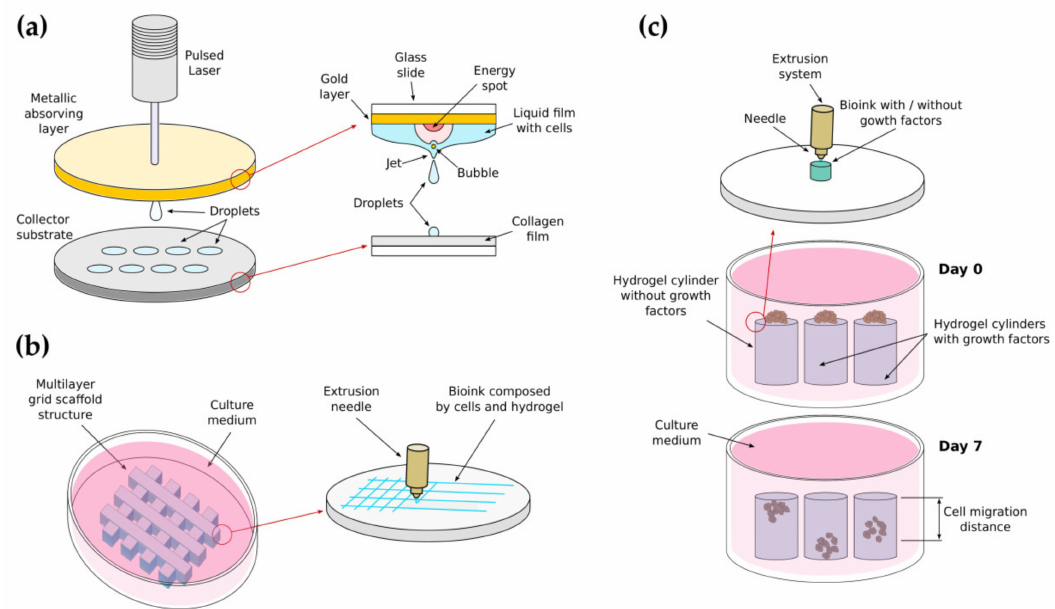
Figure 5. Bioprinted devices for cell migration assays. ( a ) Patterned bioprinted scaffold for cultivating endothelial cells and mesenchymal cells in collagen (Adapted from [291]); ( b ) Grid-shape-cubic scaffold for modeling lung cancer invasion/migration assays (Adapted from [292]); ( c ) hyaluronic acid (HA)-based cylinder used as scaffold for measuring Schwann cells migration capacity under different growth factors effect (Adapted from